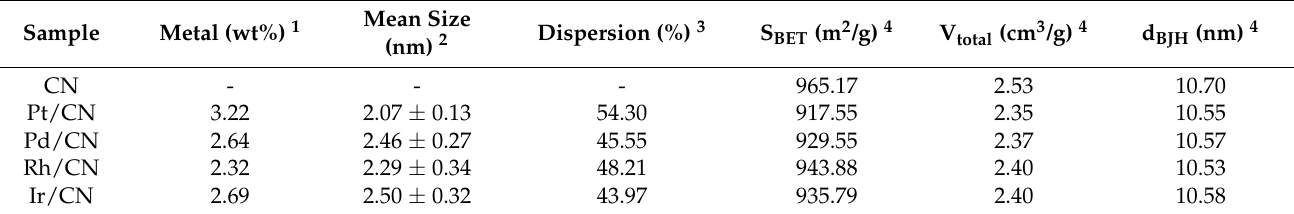
Table 1. The physicochemical properties of the CN support and synthetic